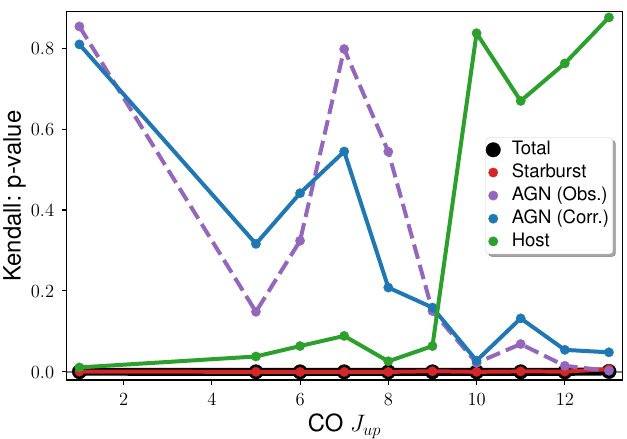
Figure 1. The p -values from the Kendall- τ tests, comparing the CO luminosities to the total, starburst, AGN, and host infrared luminosities (Sections 3.1 and 3.2). A low p -value indicates that the hypothesis of no correlation can be